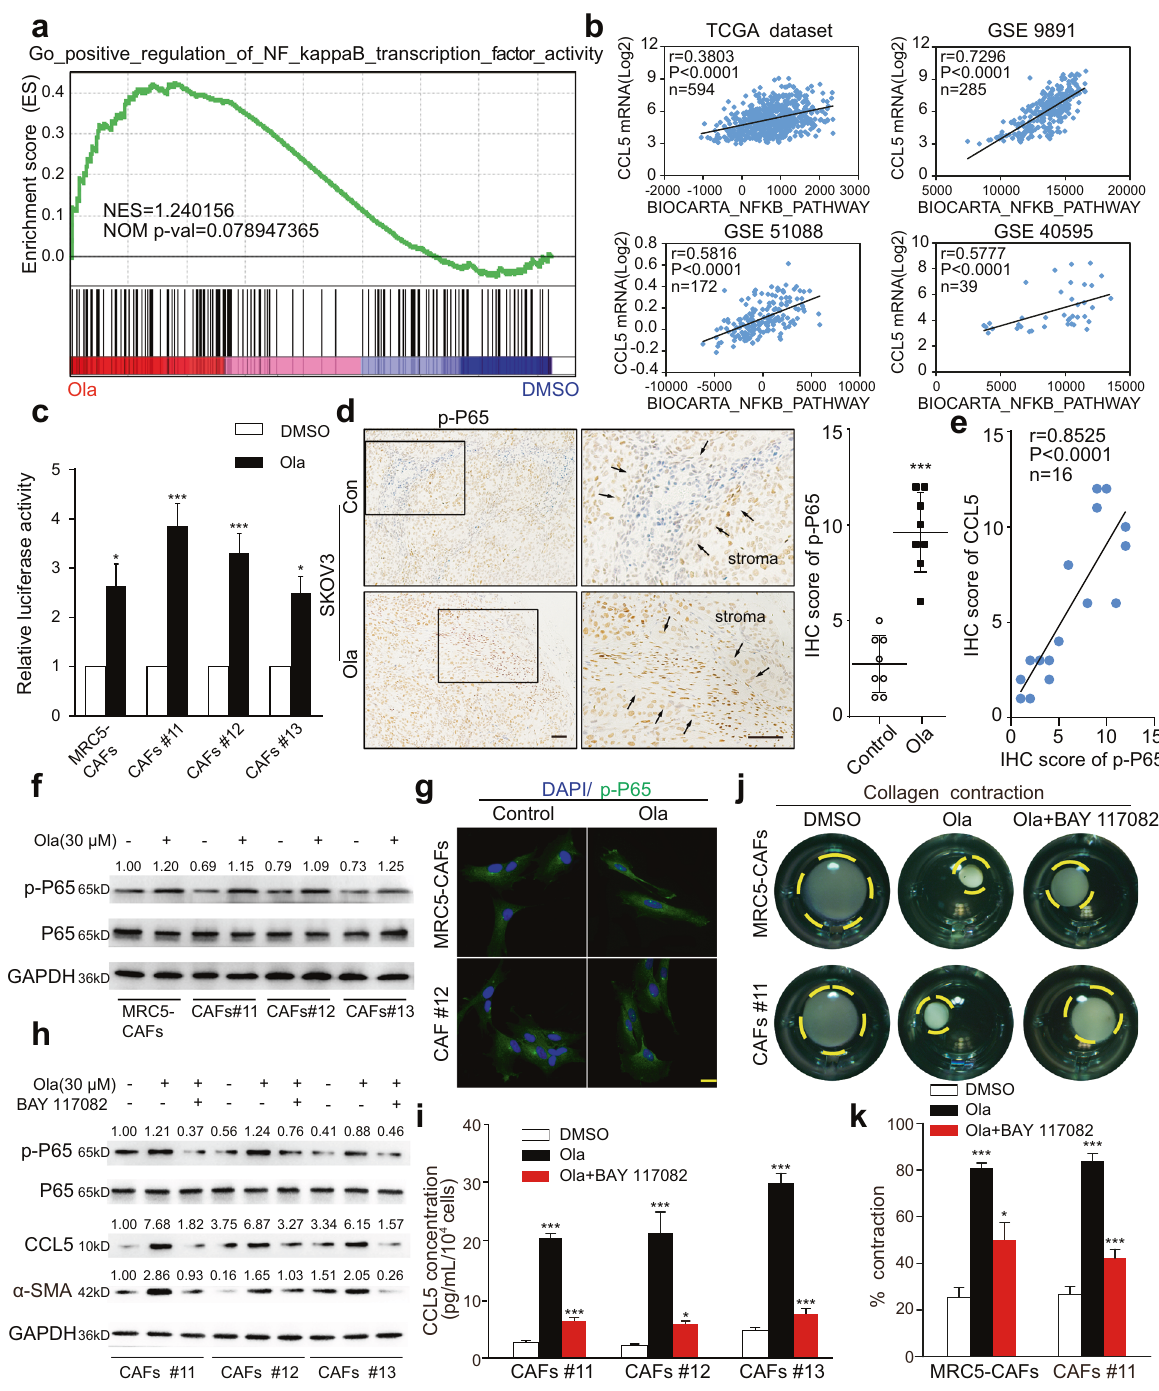
Fig. 6 PARPis induce CCL5 expression in fi broblasts through NF- κ B signaling. a GSEA of RNA-seq data showing signi fi cant enrichment for signature representing the NF- κ B pathway activation in Ola-treated CAFs. b Spearman ’ s correlation analyses showing the relationship between calculated BIOCARTA_NFKB_PATHWAY score and CCL5 expression in the TCGA dataset, GSE 9891, GSE 51088, and GSE 40595. c The luciferase activity of p-NF- κ B in CAFs with or without PARPi exposure. d Representative IHC images and quanti fi cation of p-P65 protein expression in the Ola-challenged and control tumor stroma of SKOV3 xenografts. Measurements were taken from distinct samples ( n = 8). Scale bar, 50 µm. e The correlation analysis of the IHC scores of CCL5 and p-P65 among SKOV3 tumor xenografts. f Immunoblotting analysis of p-p65 in control and Ola-induced fi broblasts. GAPDH served as the loading control. Relative densitometric values are labeled in the photographs. g Representative immuno fl uorescence images of p-P65 in CAFs in the presence or absence of Ola. Scale bar, 10 µm. h Immunoblotting analysis of p-P65, CCL5, and α -SMA in control and Ola-challenged fi broblasts in the presence or absence of BAY 117082. GAPDH served as the loading control. Relative densitometric values are labeled in the photographs. i ELISA analysis of CCL5 expression in CM derived from CAFs under the indicated treatment. j , k Representative images and quanti fi cation of the collagen contraction assay of CAFs under the indicated treatment. Data are expressed as mean ± s.e.m., * p < 0.05; ** p < 0.01; *** p <